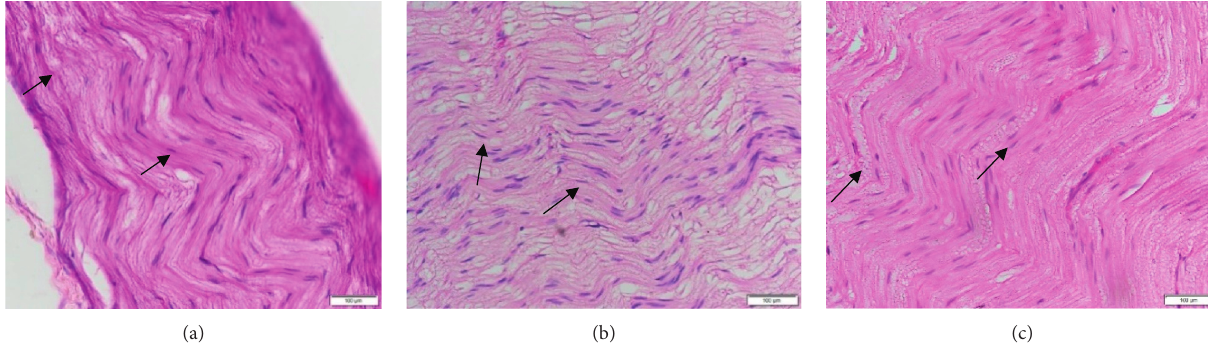
Figure 3: Characteristic of the ischiadicus nerve’s undulation with HE staining. Microscopic views under 200x magnification show normal white matter at the control group (a), moderate axonal degeneration at the AMAN group (b), and mild axonal degeneration at AMAN with the HBO group (c). The bold line arrows indicate the undulation height. Thin line arrows indicate Schwan cells. The scale bars represent 100 μ m. Table 4: Descriptive data in GSH levels of the rabbit model. Variable